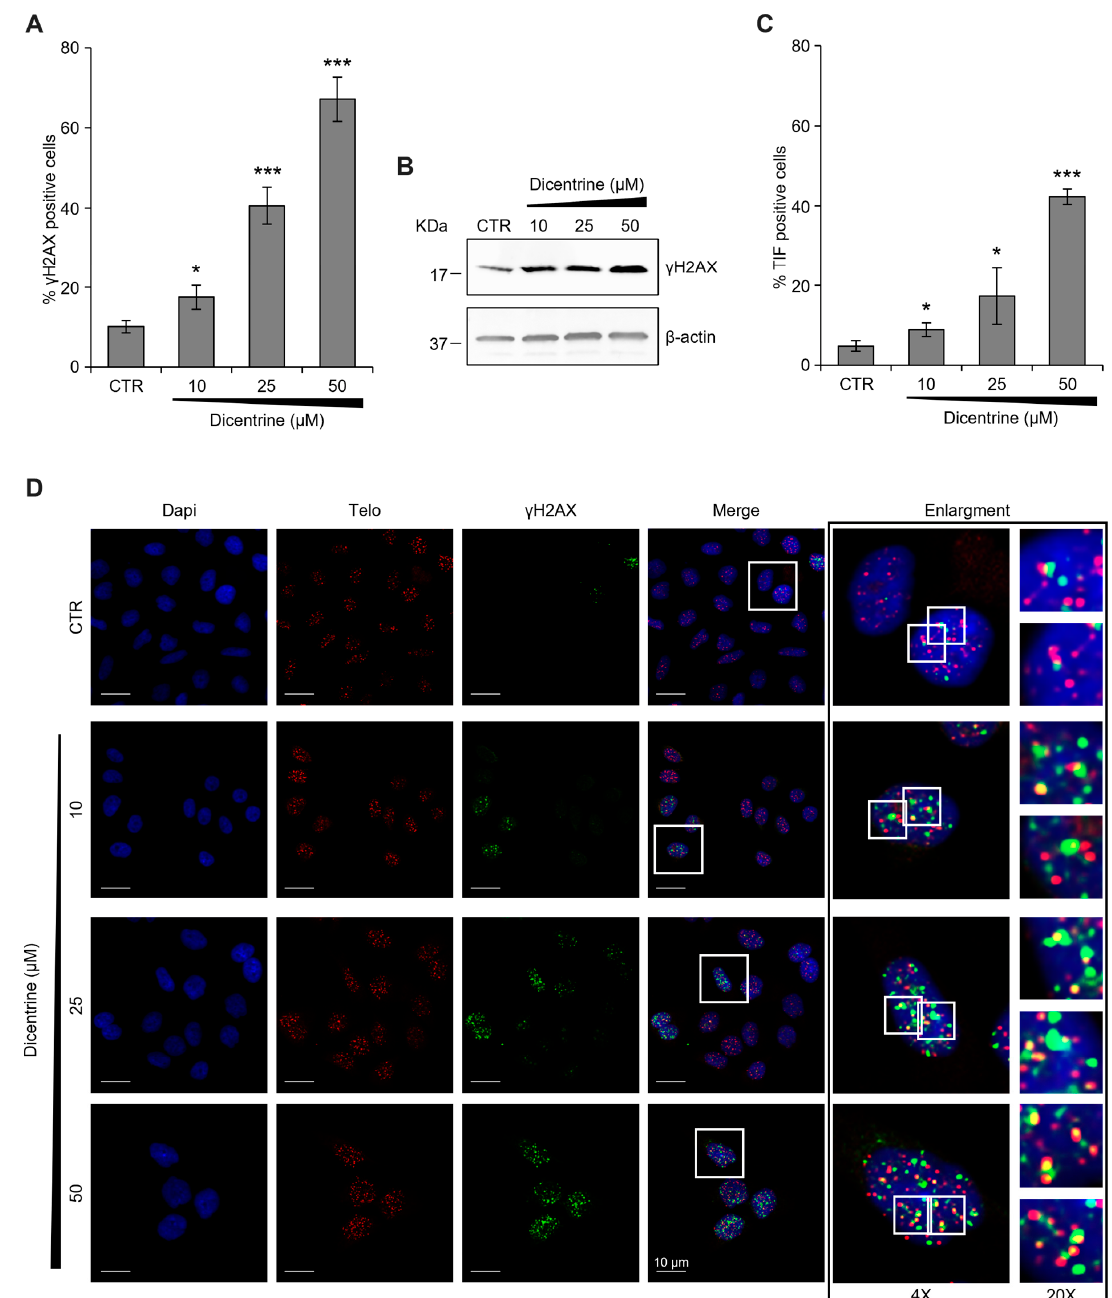
Figure 12. Dicentrine induces telomere-specific DNA damage. ( A ) HeLa cells were treated with DMSO (negative control) or with the indicated doses of Dicentrine (10, 25, 50 µ M) for 24 h. Cells were processed for telomeric FISH combined with immunofluorescence, and the amount of DNA damage was evaluated. ( A ) Quantitative analysis of damaged cells. Results are expressed as a percentage of γ H2AX positive cells over the negative control. ( B ) Western blot analysis of γ H2AX levels. B-actin protein levels were used as the loading control. ( C ) Quantitative analysis of the percentage of TIF-positive cells. Cells with at least four γ H2AX-Telo colocalizations were scored as TIF-positive. ( D ) Representative images of confocal sections (63 × ) used for the quantitative analyses reported in ( A , C ). DAPI counterstained nuclei (blue), telomeres (red), γ H2AX (green) and merged images are shown. For each experimental condition, 4 × and 20 × enlargements of merged fields are reported (white boxes). Scale bars (10 µ m) are shown in the figures. Histograms show the mean ± SD of three independent experiments performed in triplicate. * p < 0.05; *** p <